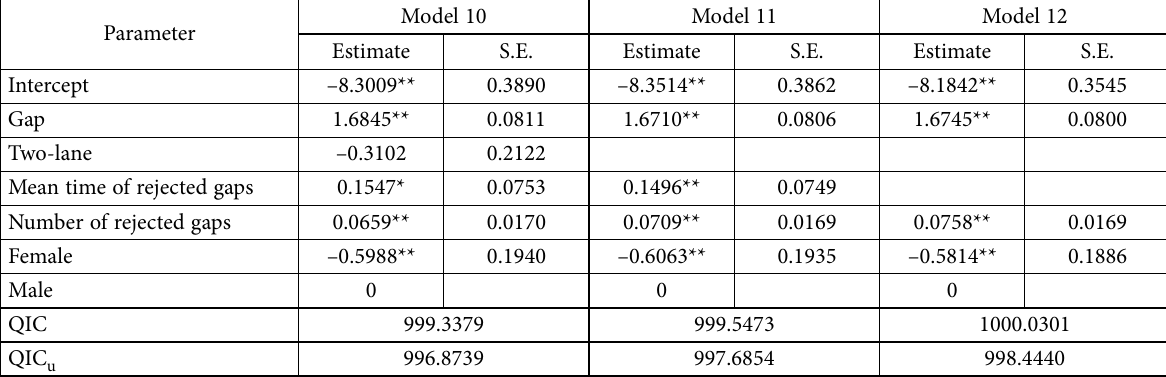
Table 8. Parameter estimates of the models on the mean time interval of rejected gaps